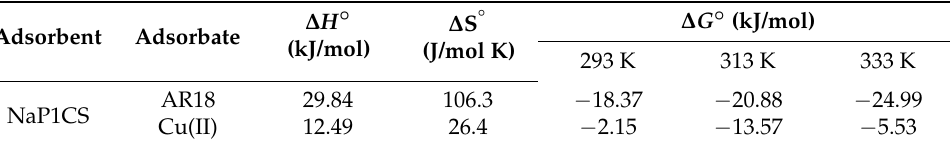
Table 5. Thermodynamic parameters for Acid Red 18 and Cu(II) adsorption on NaP1 and NaP1CS. Adsorbent